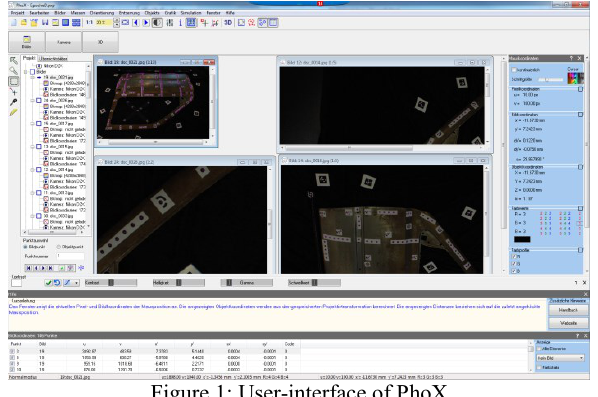
Figure 1: User-interface of PhoX